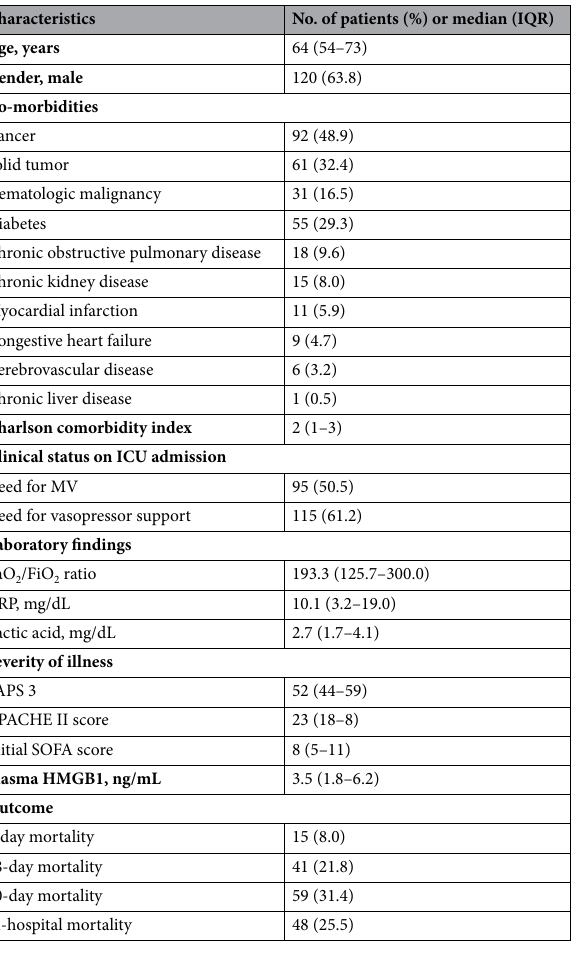
Table 1. Baseline characteristics of the 188 patients who participated in the derivation cohort. APACHE II, acute physiology and chronic health evaluation II; CRP, C-reactive protein; HMGB1, high-mobility group box-1; ICU, intensive care unit; IQR, interquartile range; MV, mechanical ventilation; SAPS 3, simplified acute physiology score 3; SOFA, sequential organ failure